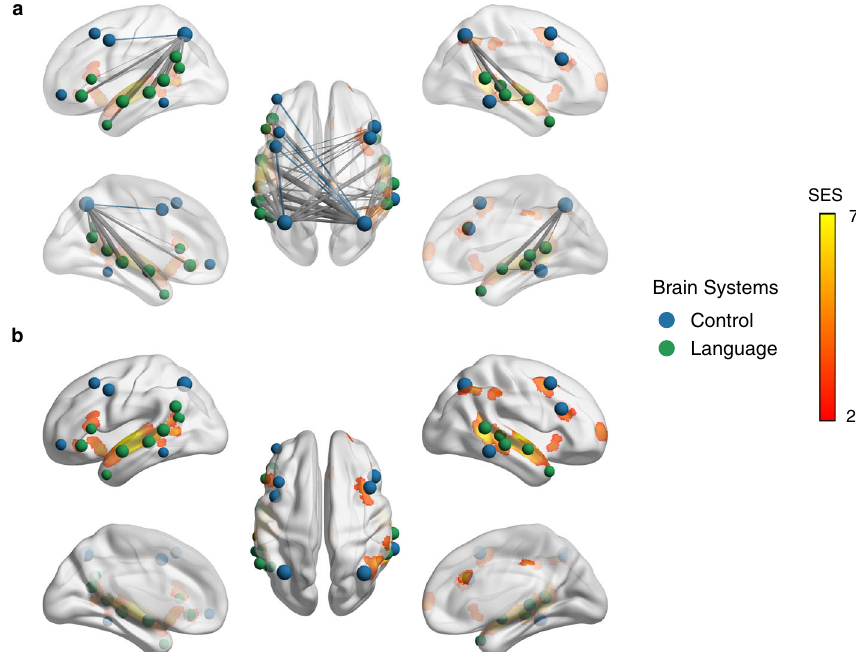
Fig. 6 Consistency between the ISC and the ISFC results for argumentative texts comprehension. This fi gure shows top 40 signi fi cant ISFC with the largest effect size in the contrast between the intact-argumentative condition and the scrambled-argumentative condition within the language and the control systems, and their overlapping with the ISC results in the contrast between the intact-argumentative condition and the resting-state condition ( P < 0.05, FDR corrected; cluster size >500 mm 3 ). The fi gure shows that the intact-argumentative condition increased the functional couplings between the regions that showed comparable ISC values to the scrambled-argumentative condition. a High visibility of the edges by decreasing the opacity of the brain surface. b High visibility of the ISC results by increasing the opacity of the brain surface. The color of the nodes denotes to which brain system they belong. The width of the edges denotes the SES. Intra-system edges are in the color of that network; inter-system edges are in